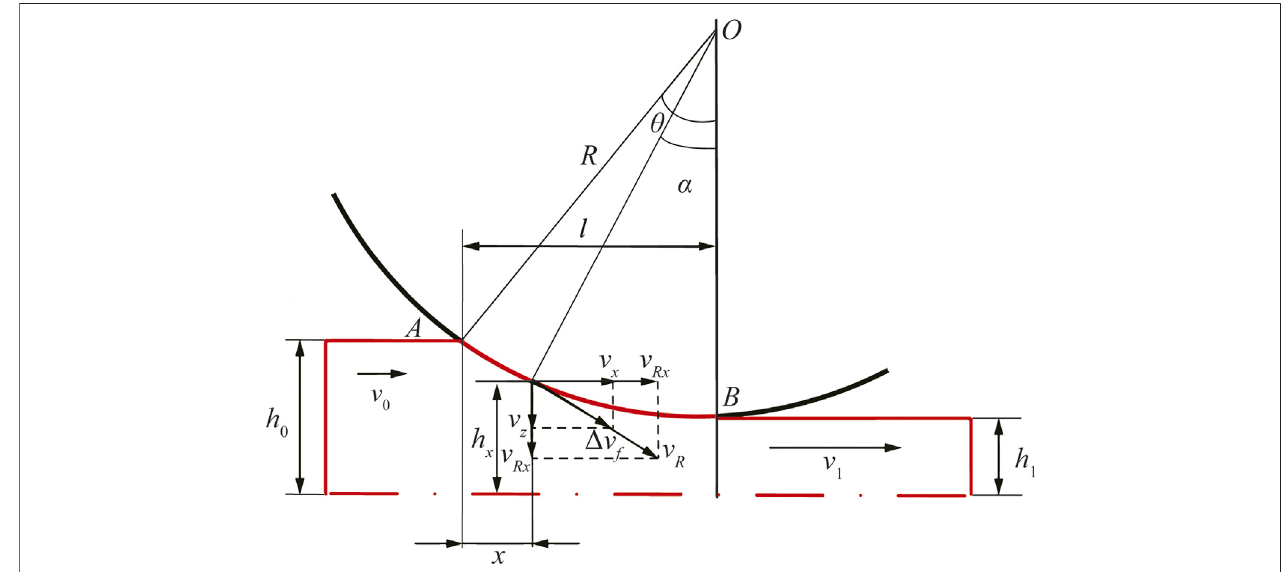
FIGURE 5 | The thick plate in the rolling deformation